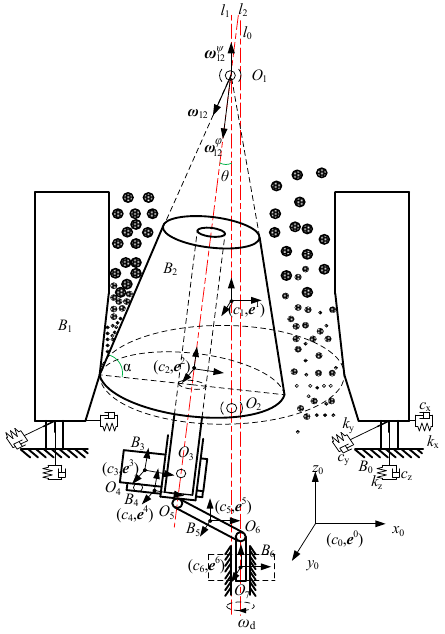
Figure 2. Simplified multibody model of an inertia cone crusher with bonded particles .